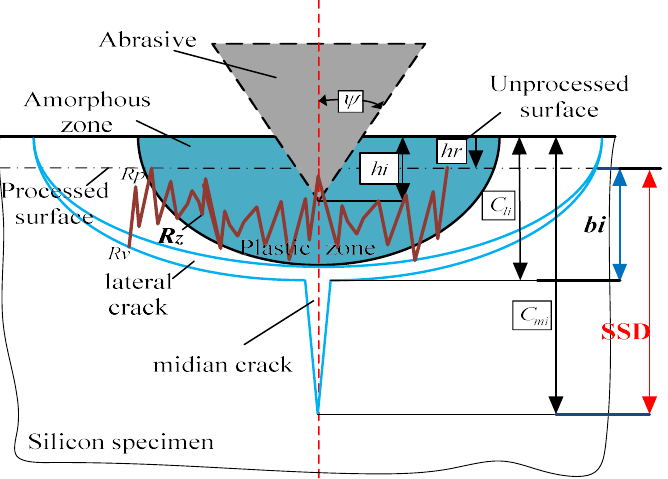
Figure 6. Schematic of subsurface-damage by an abrasive. the maximum peak height and valley depth of the ground surface roughness are be- tween the ground surface and the bottom bi of the plastic zone [19].